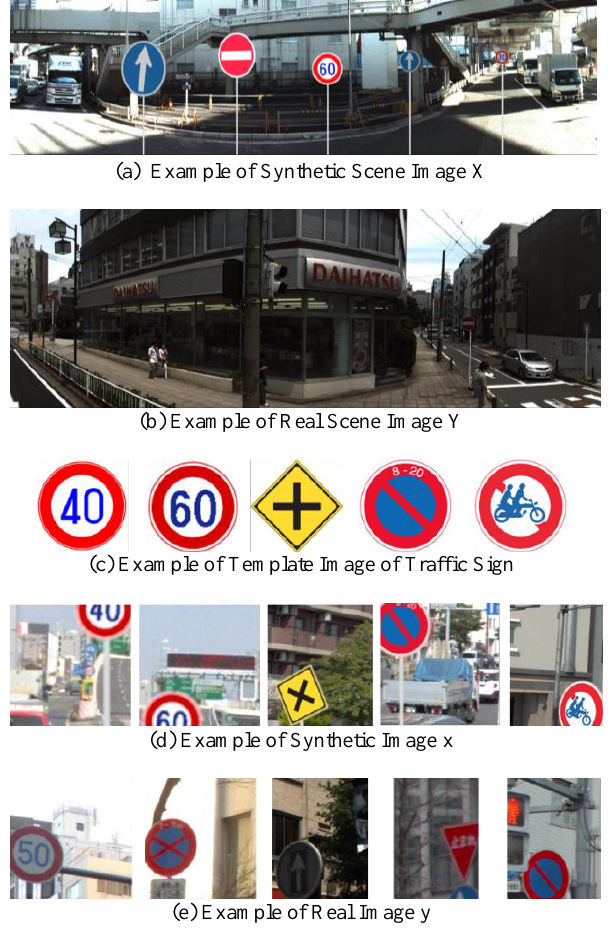
Figure 6. Example of Our